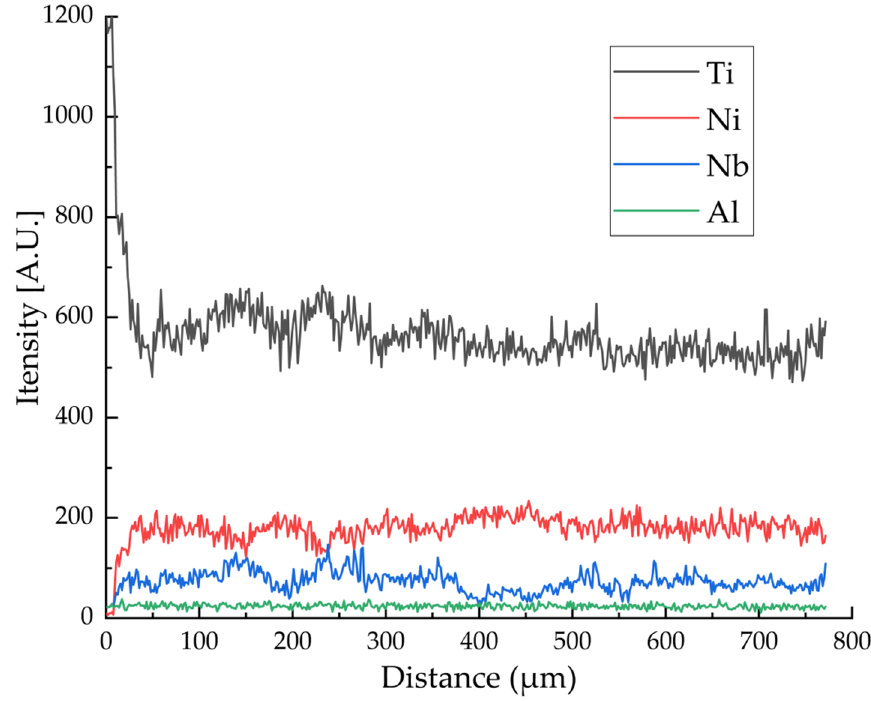
Figure 6. EDS line scans across the NiTi-Nb-Ti 2 AlNb interface (No. 3 sample). Table 2. Chemical analysis of different regions in Figure 5a (at. %, No. 3 sample). Region